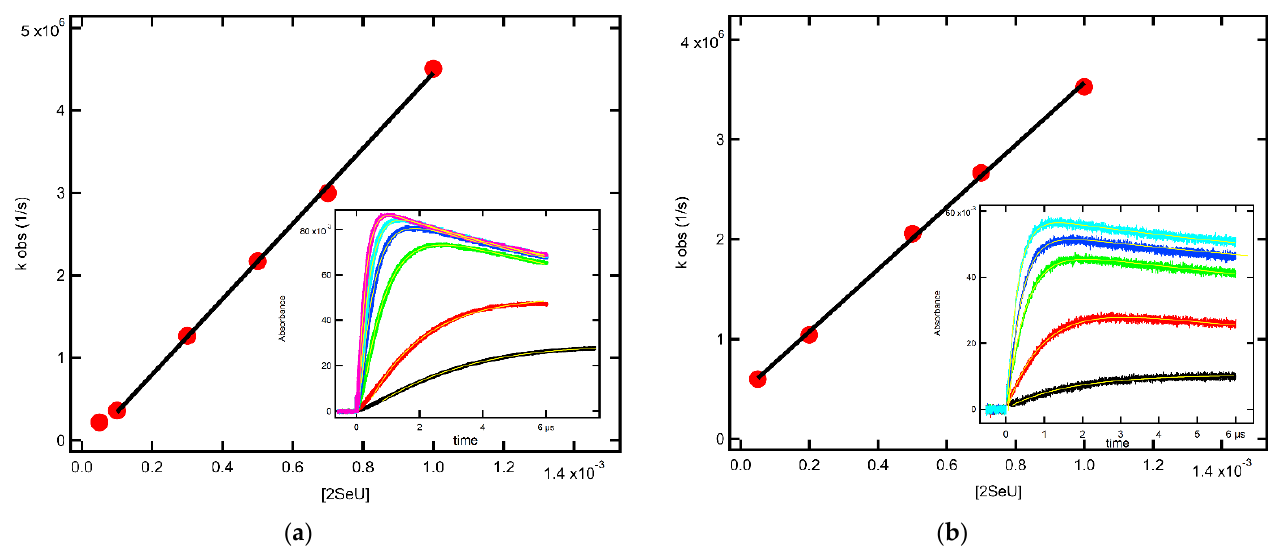
Figure 4. ( a ) Plots of the observed pseudo-first-order rate constants of the formation of the 440 nm absorption as a function of 2-SeU concentration in N 2 O-saturated unbuffered aqueous solutions at pH = 4. Inset: Time profiles of transient absorption at λ = 440 nm at various concentration of 2-SeU: from the bottom 0.05 mM ( − ), 0.1 mM ( − ) , 0.3 mM ( − ), 0.5 mM ( − ), 0.7 mM ( − ), and 1 mM ( − ); ( b ) plots of the observed pseudo-first-order rate constants of the formation of the 440 nm absorption as a function of 2-SeU concentration in N 2 O-saturated unbuffered aqueous solutions at pH = 10. Inset: Time profiles of transient absorption at λ = 440 nm at various concentration of 2-SeU: from the bottom 0.05 mM ( − ), 0.2 mM ( − ), 0.5 mM ( − ), 0.7 mM ( − ), and 1 mM ( −